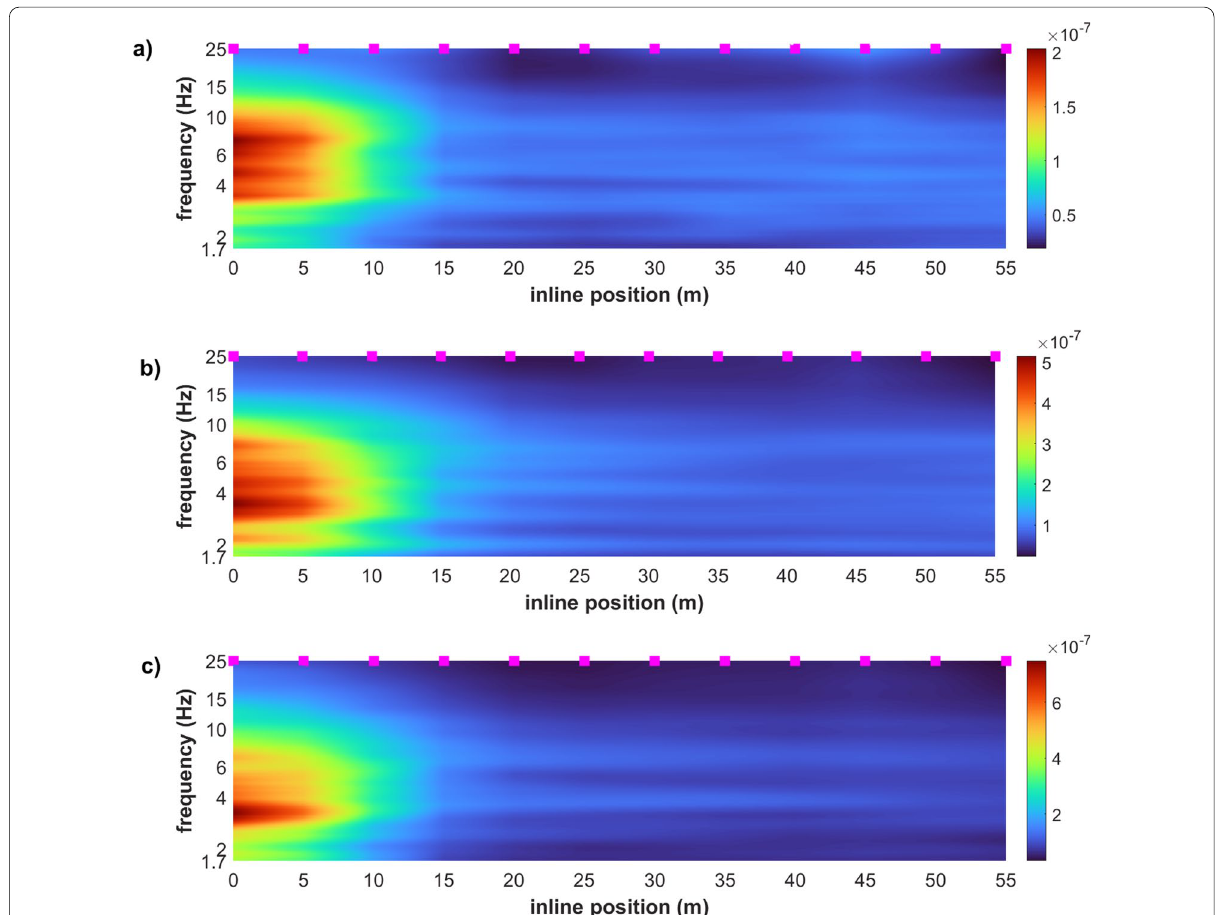
Fig. 17 Beligna#1—3-component (passive) seismic data: mean amplitude spectra for the Z [vertical] ( a ), EW [Radial] ( b ) and NS [Transversal] ( c ) components. The magenta points indicate the location of the 12 traces along the 55 m array. Compare with data presented in Figs. 13, 15, 16 and 18. See text for further